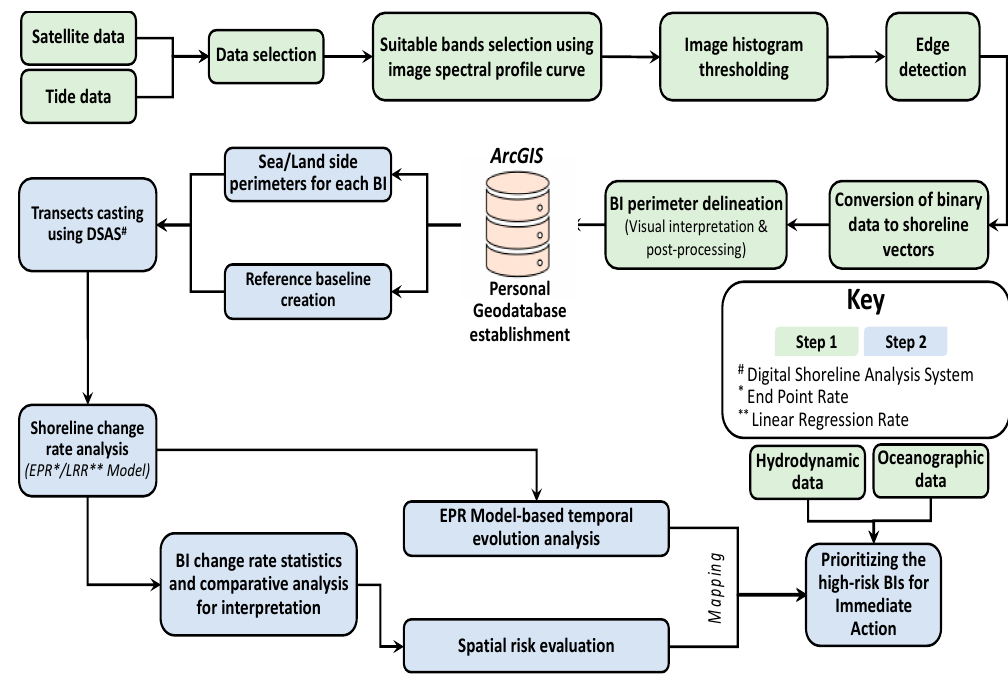
Figure 2. Schematic of the overall research workflow.